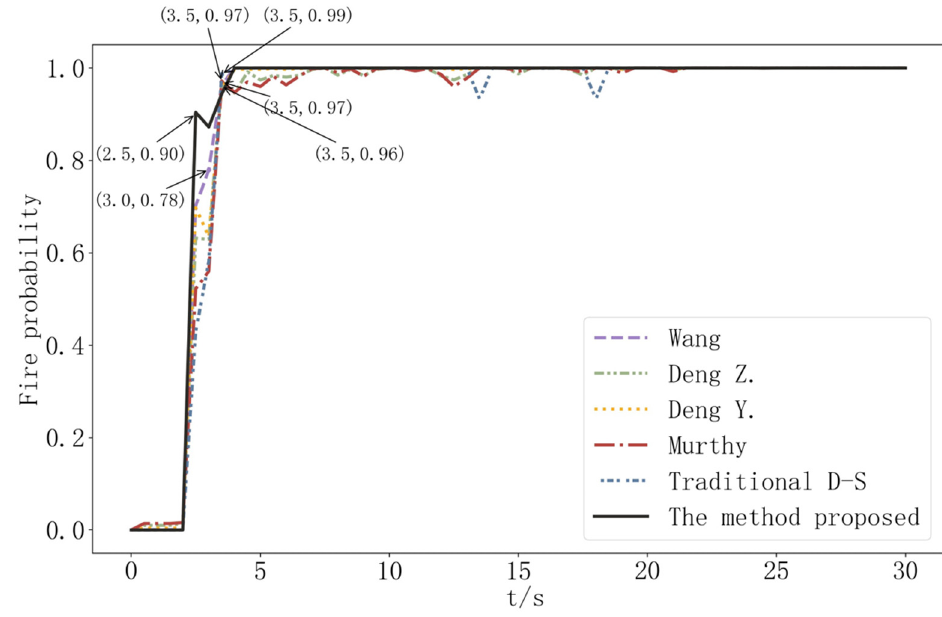
Figure 9. Fire occurrence probability comparison in open fire scene.